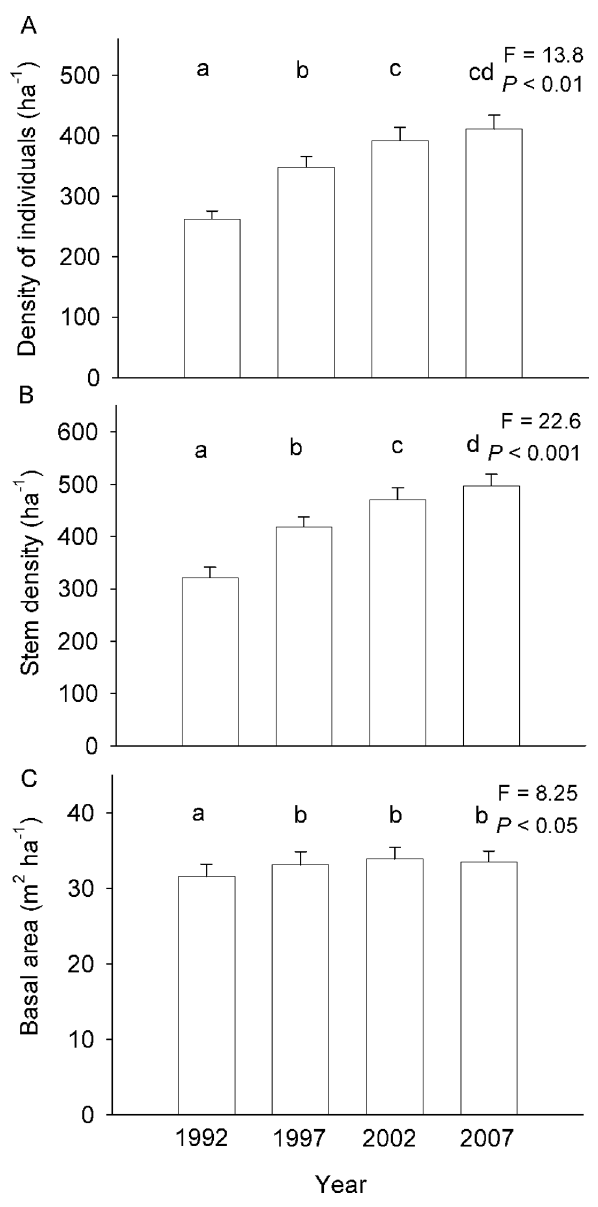
Figure 2. Structural changes in 15 years. a) Changes in density of individuals, b) density of stems, and c) basal area in all four census. Letters identify non-different groups from Friedman ANOVA and posteriori Wilcoxon match pair tests. Error bars correspond to standard error. All data are the per-hectare average of 8 ha.